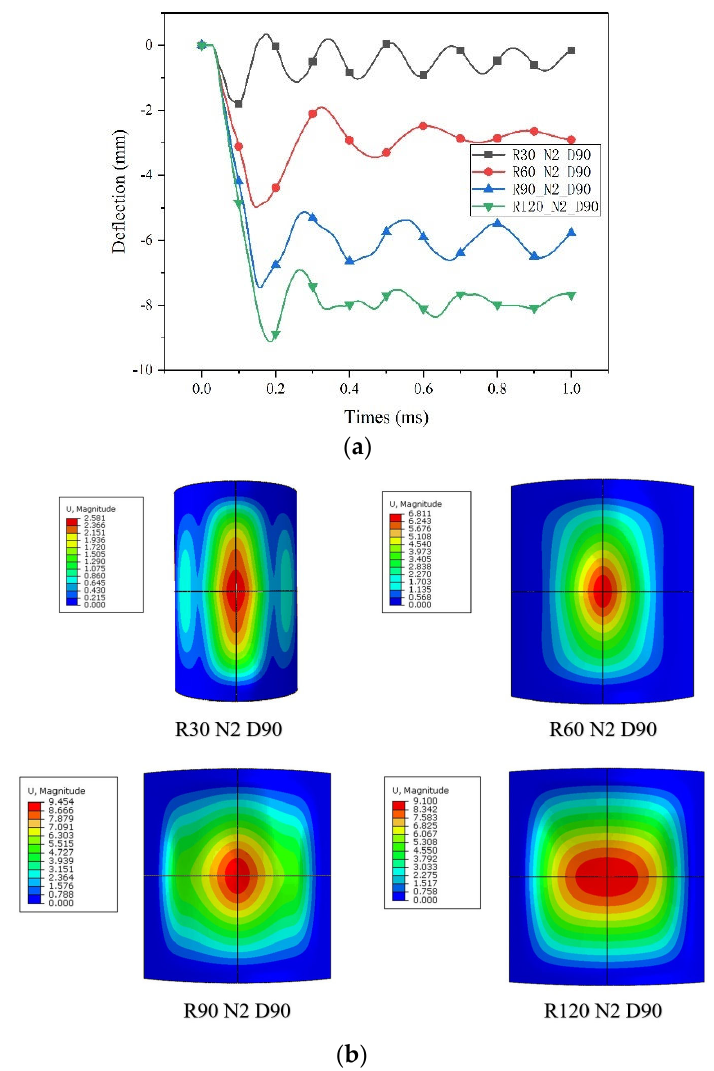
Figure 12. Deformation–time history diagram of double-layer CARALL structures with different radii of curvature.